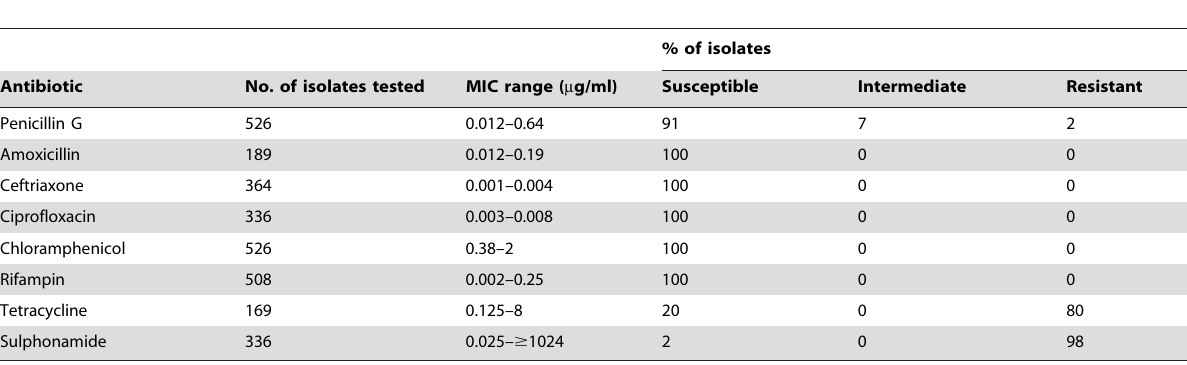
Table 2. Antibiotic susceptibility of invasive meningococcal isolates from sub-Saharan Africa in 2004–2010.